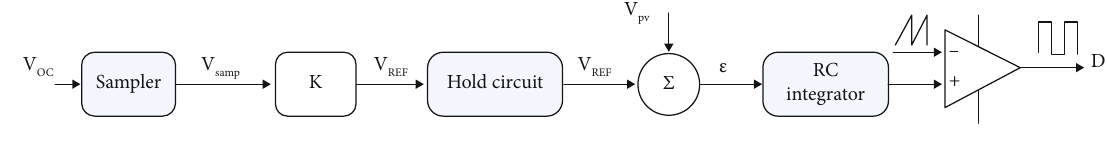
Figure 8: MPPT using the constant voltage method. V Table 4: V OC and MPP voltage responses versus temperature.